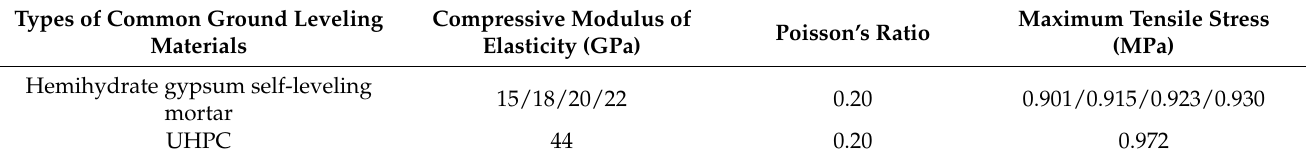
Table 6. Tensile stress corresponding to different Poisson’s ratios and compressive elastic moduli of sand-free gypsum self-leveling mortar layer.